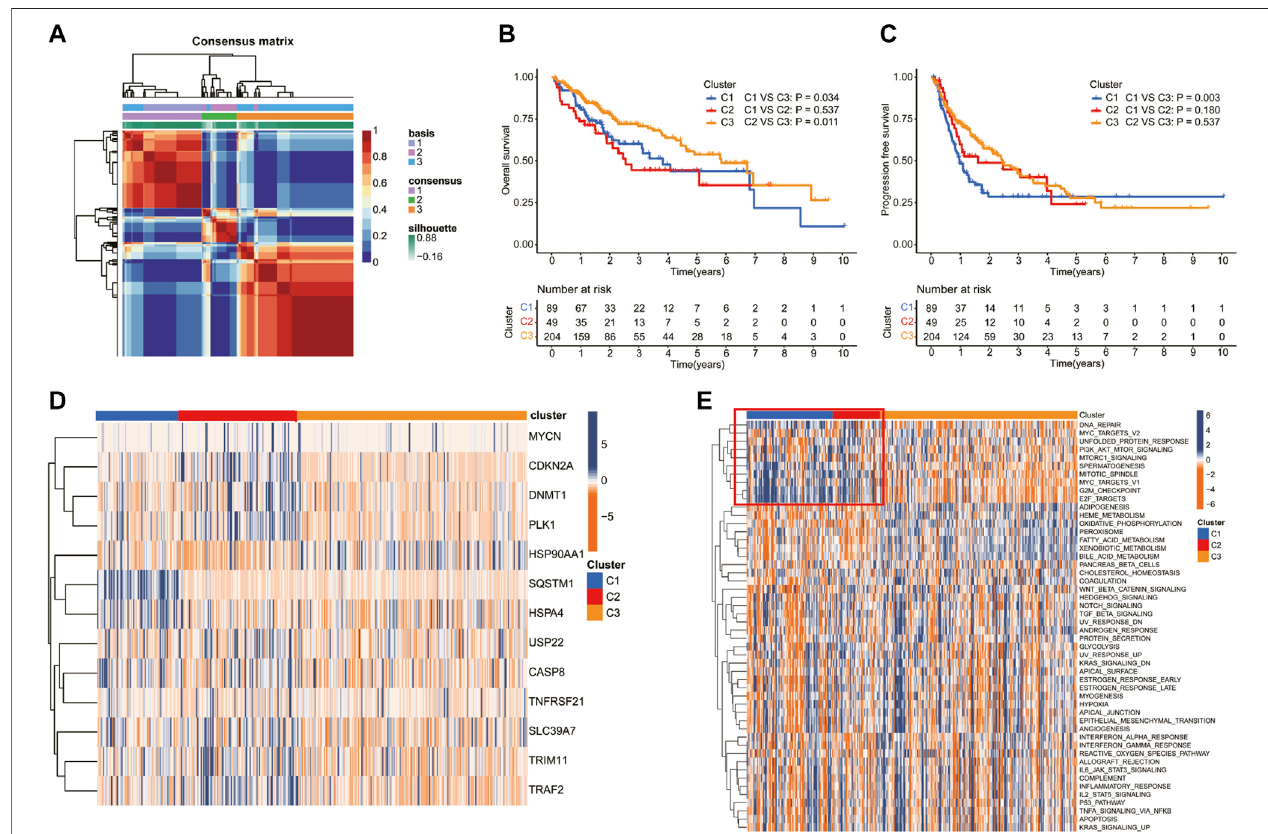
FIGURE 3 | Screening of molecular subgroups through the nonnegative matrix factorization (NMF) cluster. (A) Consensus map of NMF clustering. The Kaplan – Meier(K – M)analysisof (B) overallsurvivaland (C) progression-freesurvivalforpatientsindifferentclusters. (D) HeatmapoftheNRGexpressionofthemolecular subtypes. (E) Heatmap showed the ssGSEA Z-scores of 50 hallmarks among the three clusters.